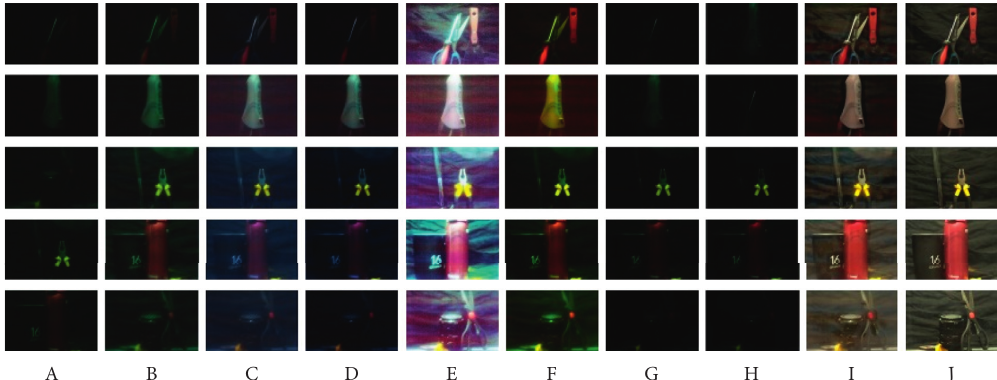
Figure 9: The testing comparison between our algorithm and underwater enhancement and restoration algorithms. The columns from A to J, respectively, mean the results: original image, by CLAHE [11], by Gamma Correction (GC) [3, 52], by ICM [14], by Rayleigh Distribution [53], by UCM [54], by RoWS [55], by UDCP [22], by our algorithm, and the reference